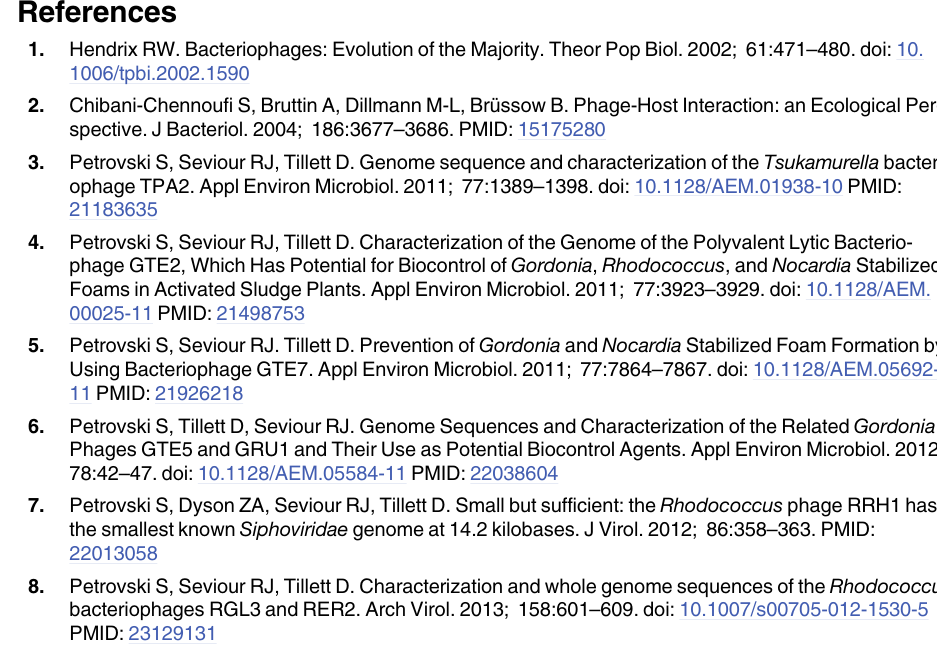
S2 Table. Prophages detected in plasmid sequences using